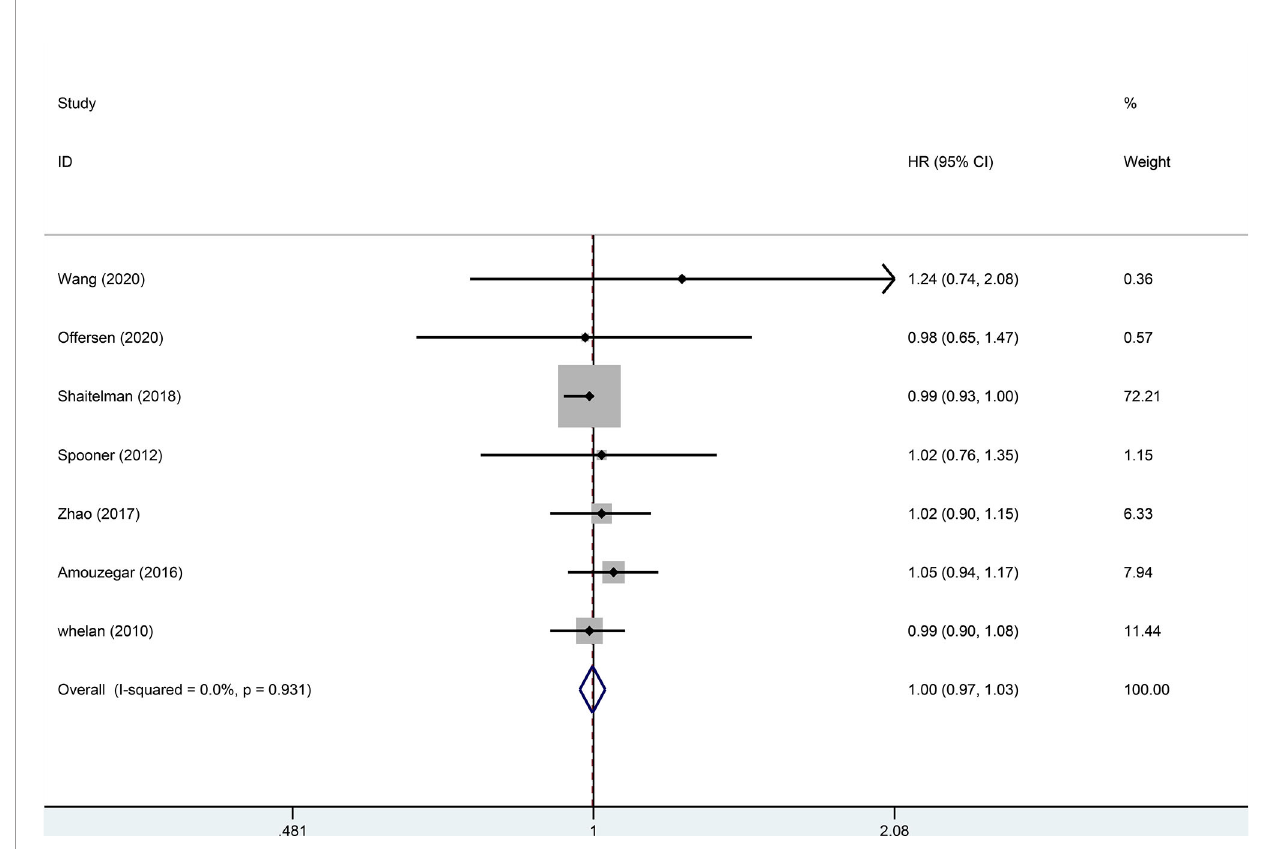
FIGURE 4 | Forest plot of hypofractionated radiotherapy (HFRT) vs . conventional radiotherapy (CFRT) for overall survival ( p = 0.879).